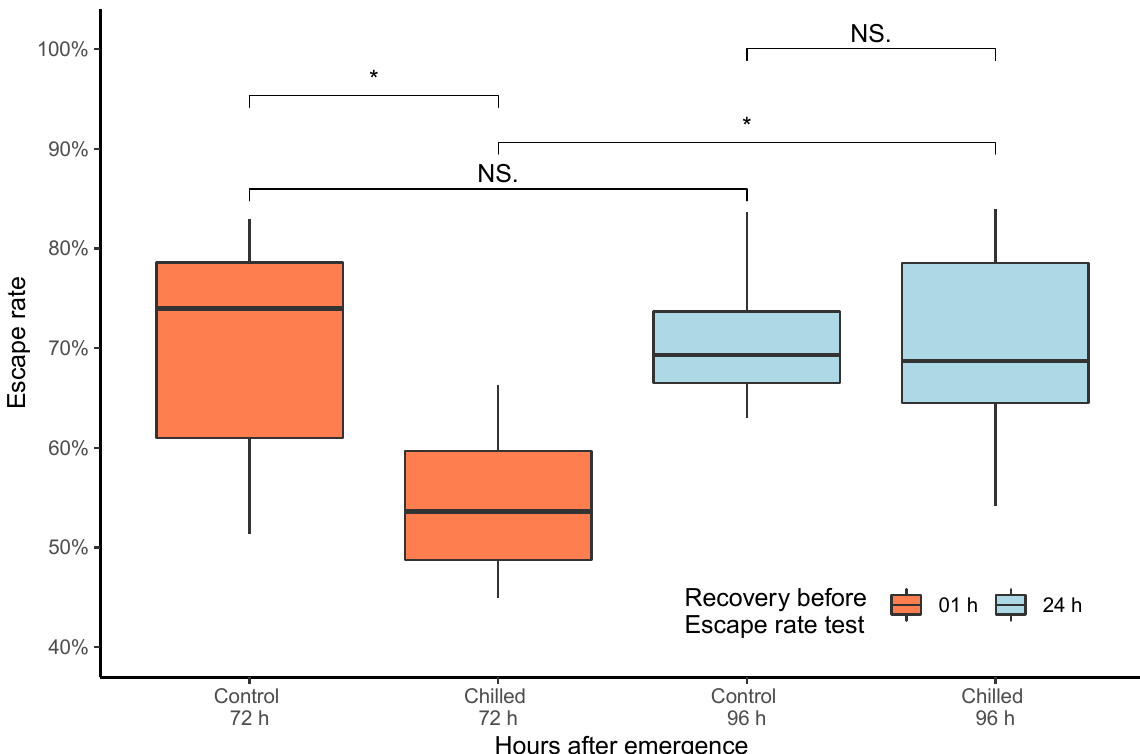
Figure 2. Aedes mosquito male escape rates after chilling at 4 °C for 60 min without compaction. Except for the controls (which only represent hours after emergence), the light blue group (96 h) was exposed to chilling at the same time as the 72 h, but they had 24 h to recover prior to the escape rate test. Significance values goes as ‘*’ < 0.05, ‘NS’ < 1. The boxplot shows the median and upper and lower quartiles.